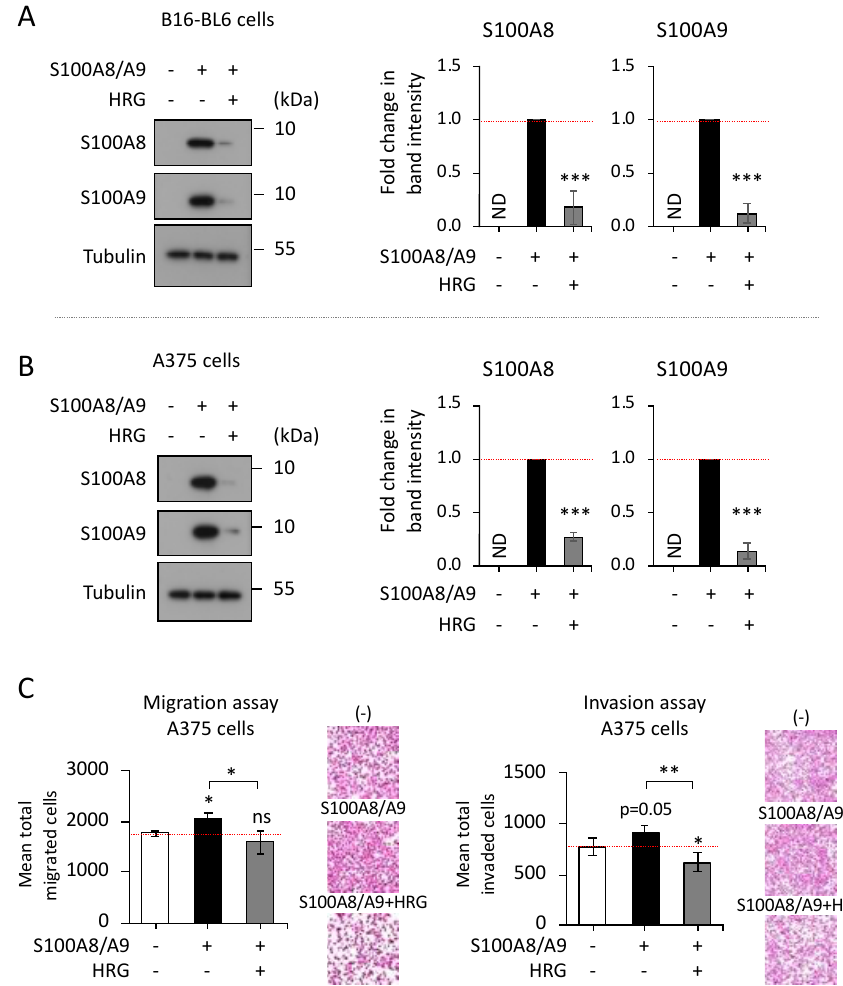
Figure 2. Prevention of the S100A8/A9-mediated migration and invasion of melanoma cells by